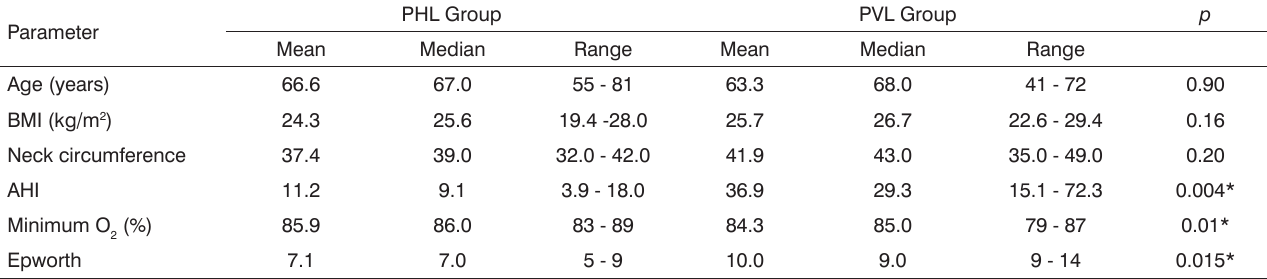
Table 1. Anthropometric, clinical, and polysomnogram data of the partial vertical laryngectomy (PVL) and partial horizontal laryngectomy (PHL) groups.